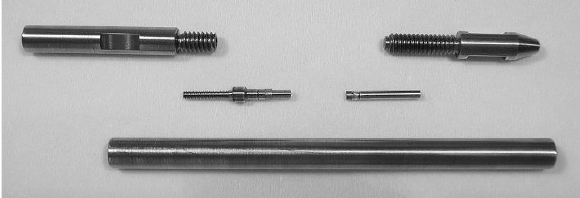
Fig. 1. Pressure cell, inner Ø = 2.5 mm and outer Ø = 8.6 mm